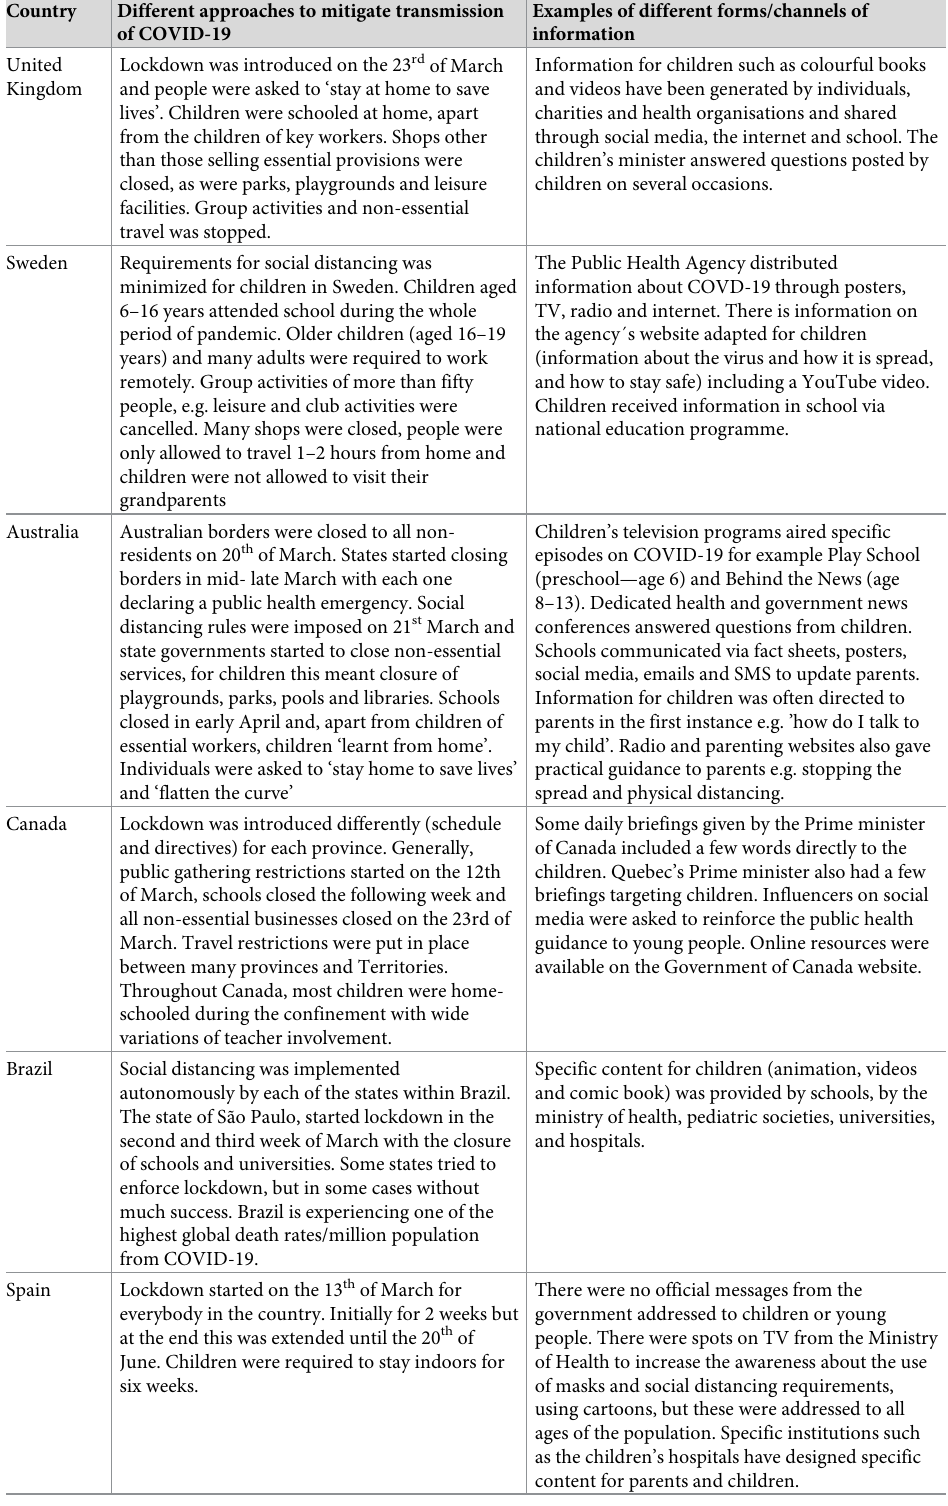
Table 1. Examples of the different approaches to mitigate transmission of COVID-19 and provide information to children about COVID-19 (coronavirus) within the participating countries during the time of the